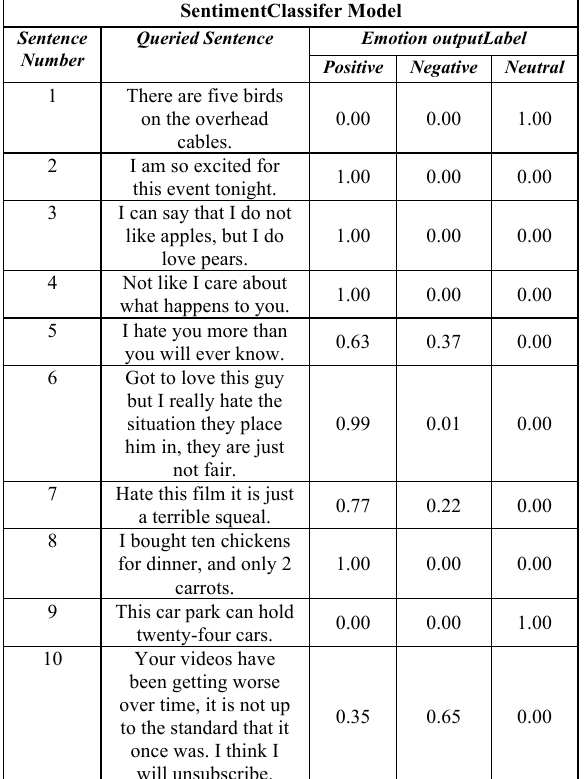
T ESTING S ENTIMENT C LASSIFER WITH ARBITRARY SENTENCES SentimentClassifer